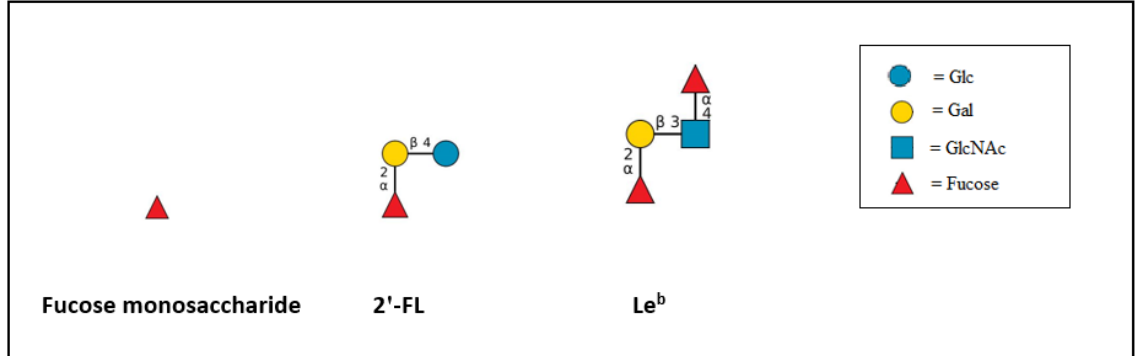
Figure 1. The schematic diagram of fucose monosaccharide, 2 ꞌ -FL, and the terminal tetrasaccharide of the Le b antigen are shown. Glc = glucose, Gal = galactose, GlcNAc = N-acetylglucosamine. The structures are drawn using DrawGlycan [26].